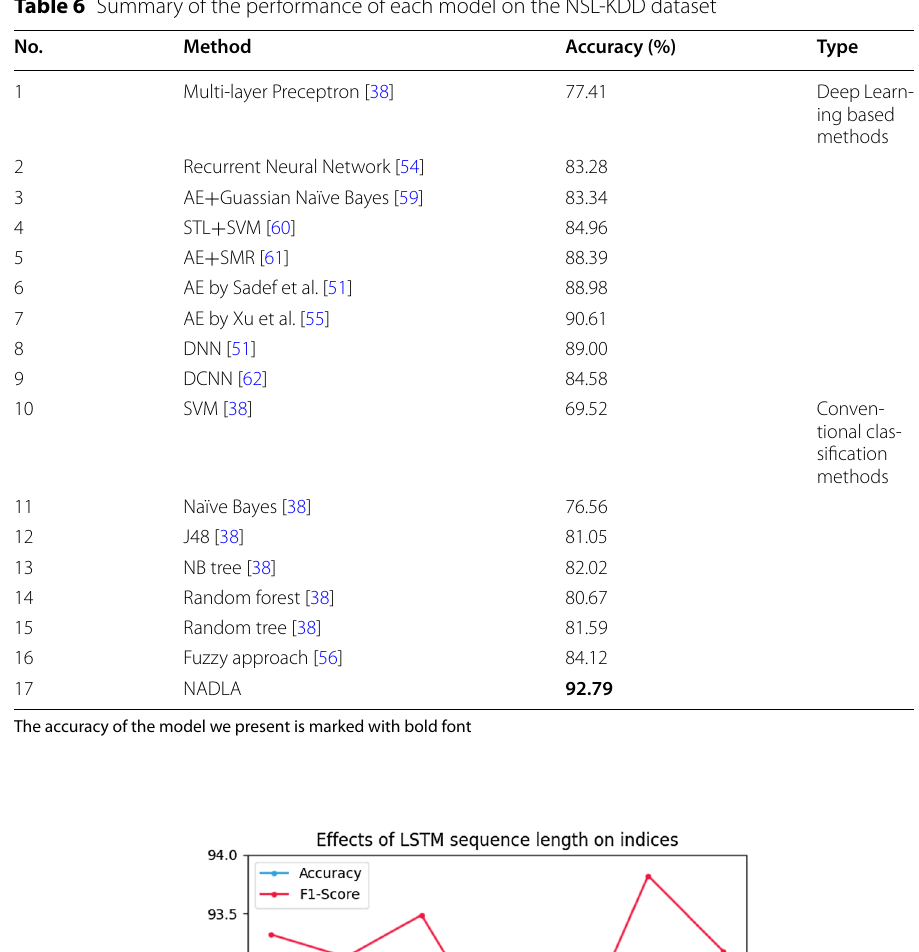
Table 6 Summary of the performance of each model on the NSL‑KDD dataset